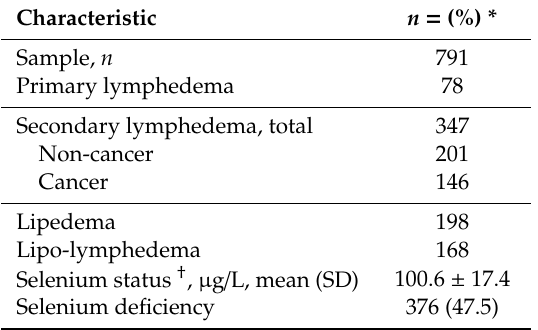
Table 1. Descriptive characteristics of patients.